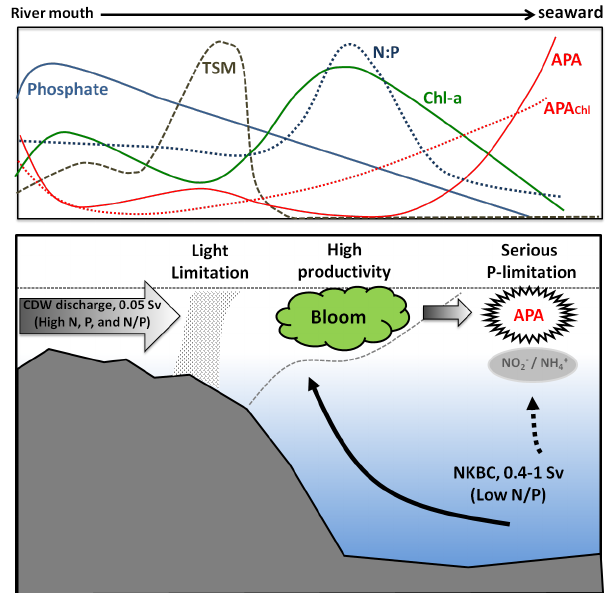
Fig. 8. Conceptual diagram for the interaction between the Changjiang Diluted Water (CDW) and coastal upwelling NKBC on algal bloom and P limitation of CJ plume. The offshore variations of the associated parameters are shown on the